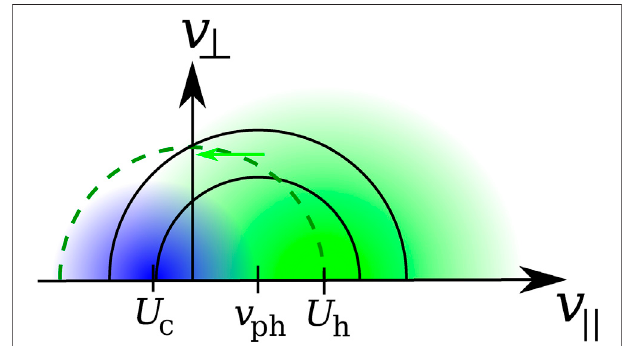
FIGURE 8 | Schematic illustration of the quasi-linear diffusion in the electron/electron-acoustic instability. The blue shaded area represents the core electron population with bulk velocity U c , and the green shaded area represents the halo population with bulk velocity U h . The electron/ electron-acousticinstabilityrequires T h ≫ T c .Theblacksemi-circlesrepresent Eq.17 forelectron-acousticwaveswithparallelphasespeed v ph .Thediffusive fl ux of Landau-resonant particles is shown by the green arrow. The green- dashed semi-circle indicates v 2 ⊥ + v 2 (cid:2) (cid:3) constant.